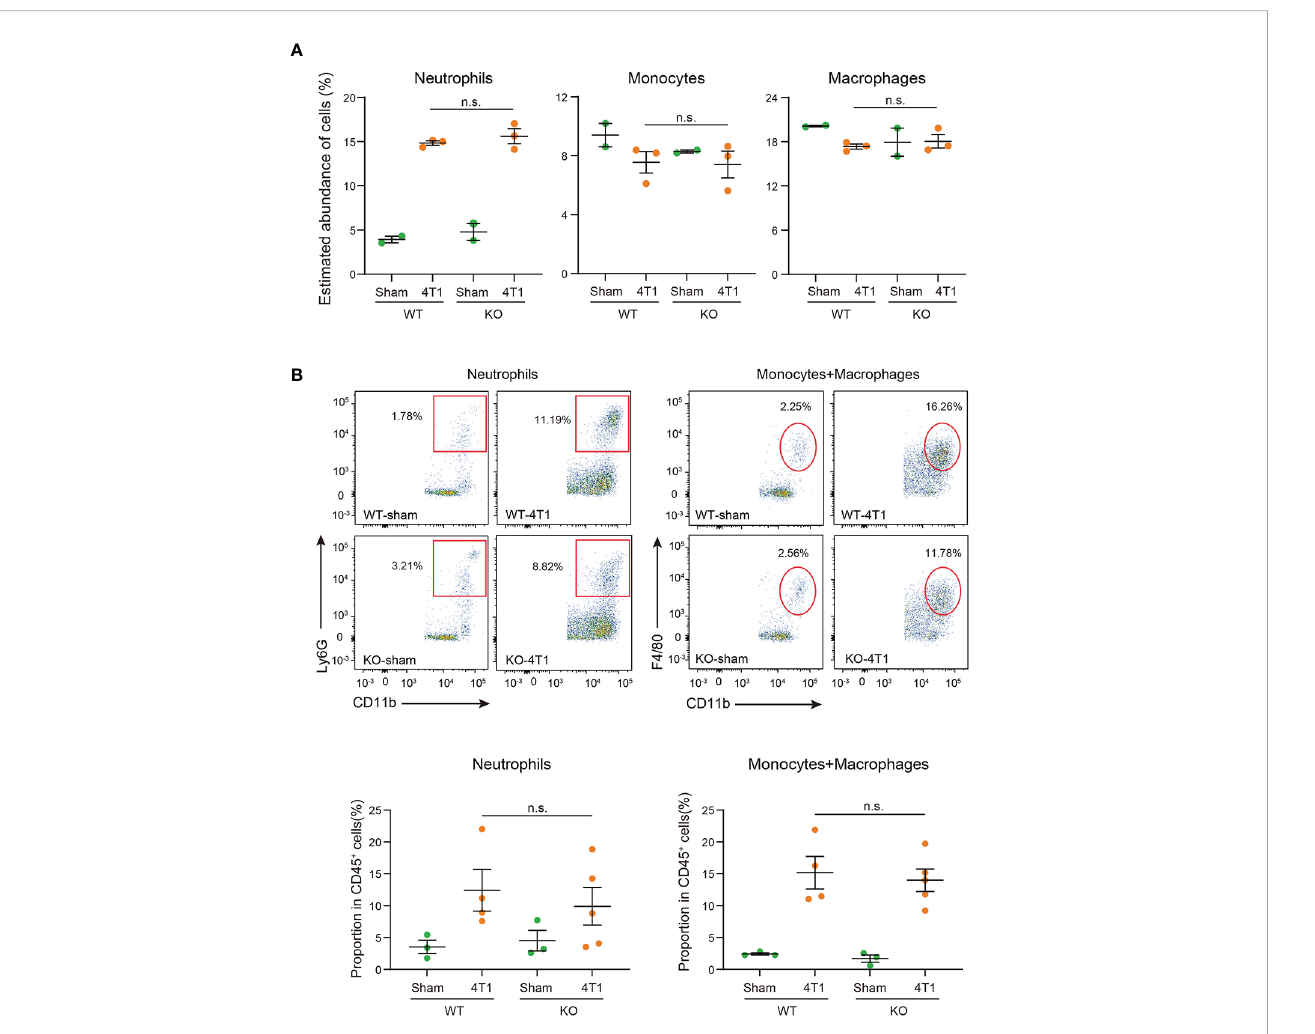
FIGURE 4 SAA1-2 are dispensable for 4T1-induced in fi ltration of immune cells to the liver (A) Dot plots showing the estimated abundance of the indicated immune cell types in the liver of sham and 4T1-bearing mice. The scores are calculated using the RNA-seq dataset in Figure 3A and ImmuCellAI-mouse. Data are presented as the mean ± SEM. n.s., not signi fi cant, unpaired two-tailed Student ’ s t -test. (B) Flow cytometric analysis of Ly6G + CD11b + neutrophils and F4/ 80 + CD11b + monocytes and macrophages in the livers of sham and 4T1-bearing mice in WT and Saa1-2 KO. Representative plots are shown. Data are mean ± SEM. The p value is shown (unpaired two-tailed Student ’ s t -test). n.s., not signi fi cant. n = 3 for the sham groups, n = 4 for 4T1-bearing WT mice, and n = 5 for 4T1-bearing Saa1-2 KO mice. See also Figure S4 for the gating strategies used in this